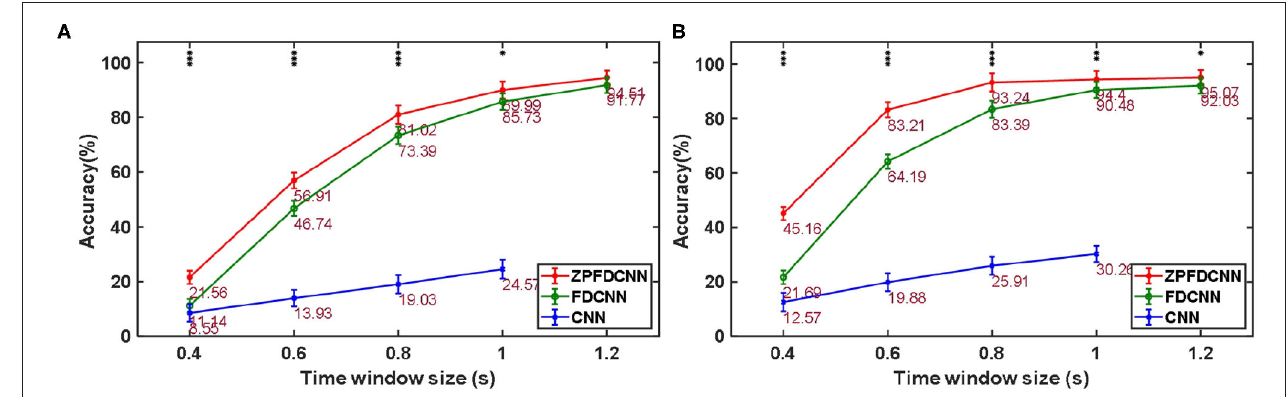
FIGURE 9 | Comparison among the ZPFDCNN method, the FDCNN method, and the CNN method. (A) Comparison on BETA:SSVEP datset. (B) Comparison on SSMVEP dataset. The error bars indicate standard errors. Note that * denotes p < 0.05, ** denotes p < 0.01, *** denotes p < 0.001 according to one-way repeated measure ANOVAs.